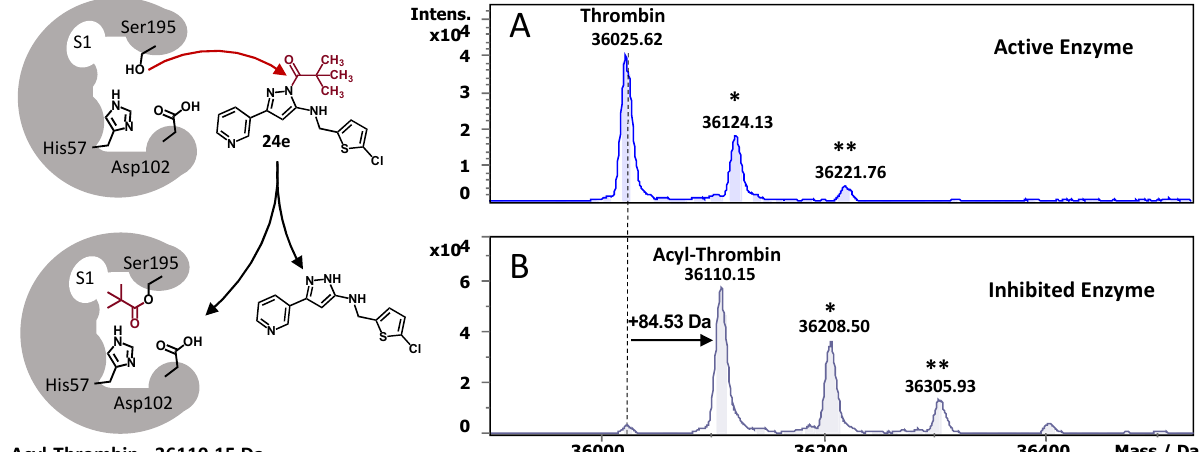
Figure 4. Deconvoluted ESI(+)-MS mass spectra of native thrombin ( A ) and acyl-thrombin complex ( B ) formed after the enzyme incubation with 79 µ M thrombin inhibitor 24e . The peaks of interest are labelled with the corresponding deconvoluted masses. A mass shift of 84.5 Da ( B ) was observed, which corresponds to the inhibitor’s acyl moiety adduct to thrombin. The schematic representation of thrombin and the covalent complexes of thrombin with the inhibitor are also shown. * — single and ** — double sulfuric acid or phosphoric acid adduct [30] .